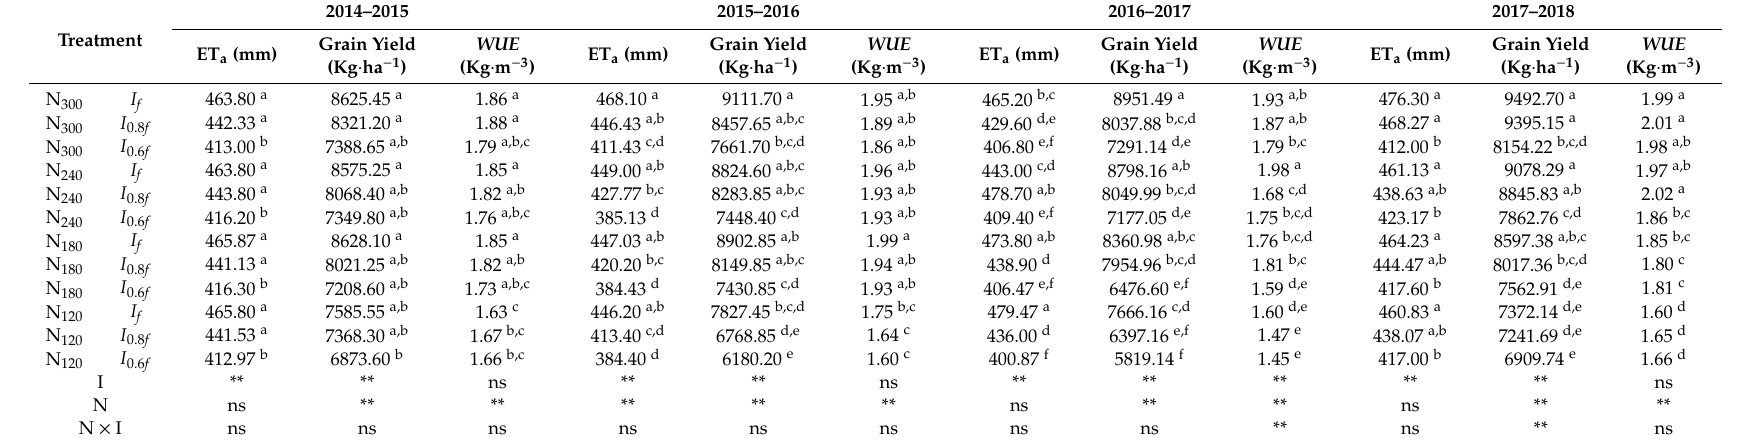
Table 4. Grain yield, Eta, and WUE of winter wheat with di ff erent treatments from 2014 to